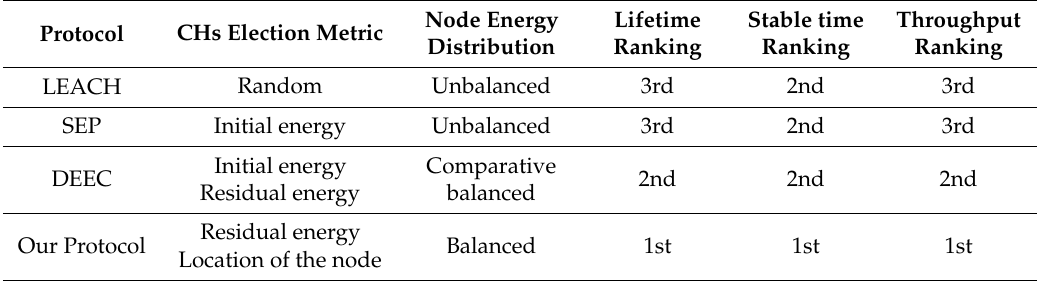
Table 6. A performance summary between the four clustering protocols in the homogeneous networks.